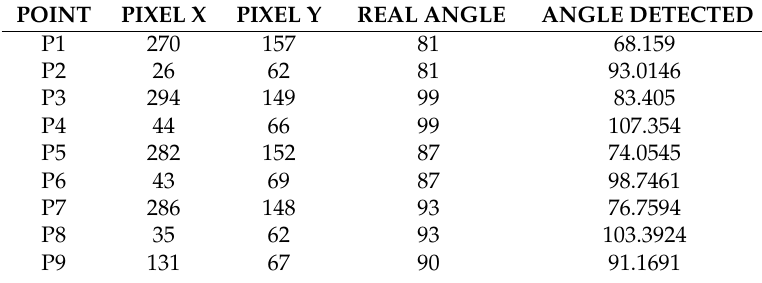
Table 1. Results obtained after having processed the information through the Fuzzy